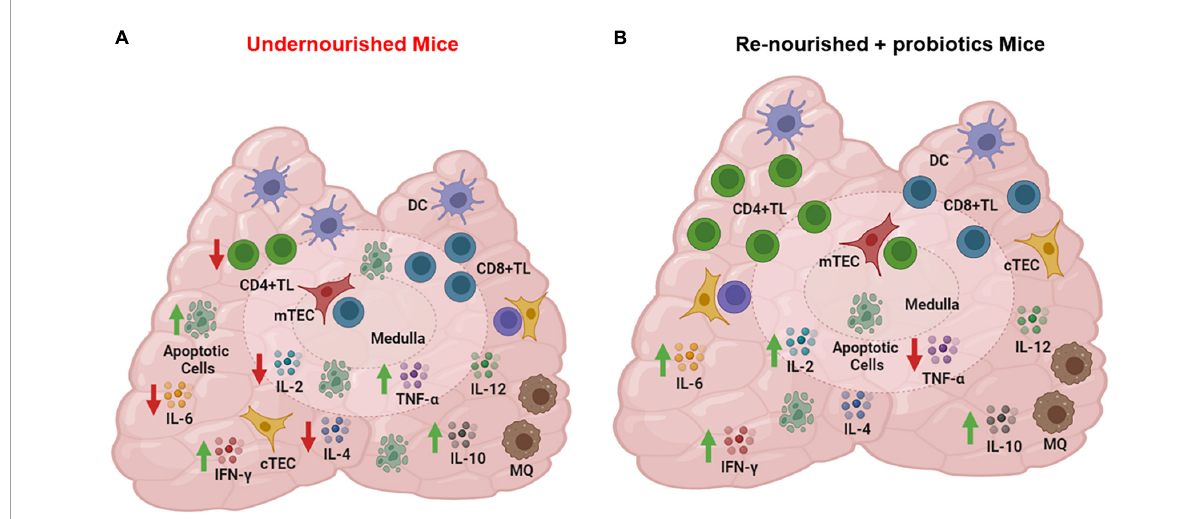
FIGURE3 Cytokine producing cells in thymus of undernourished mice. (A) Thymic cells from undernourished mice exhibited a significant reduced production of IL-2, IL-6, and IL-4 (red arrows) and a significant increased production of TNF- α , and IL-10 (green arrows). (B) Thymic cells from renourished mice fed with probiotic fermented milk showed a significant increase in the production of IFN- γ , IL-2, IL-6, and IL-10 (green arrows) and reduction of TNF- α (red arrow). Cytokine production was detected by indirect immunofluorescence assays. Figure created with BioRender.com, based on data from Maldonado Galdeano et al.